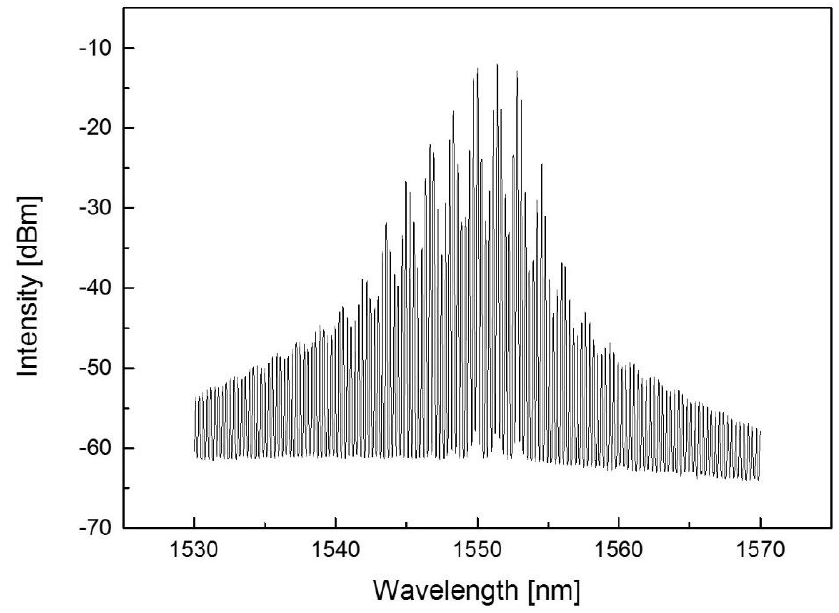
Figure 3. The spectrum of the FP-LD used for Rayleigh